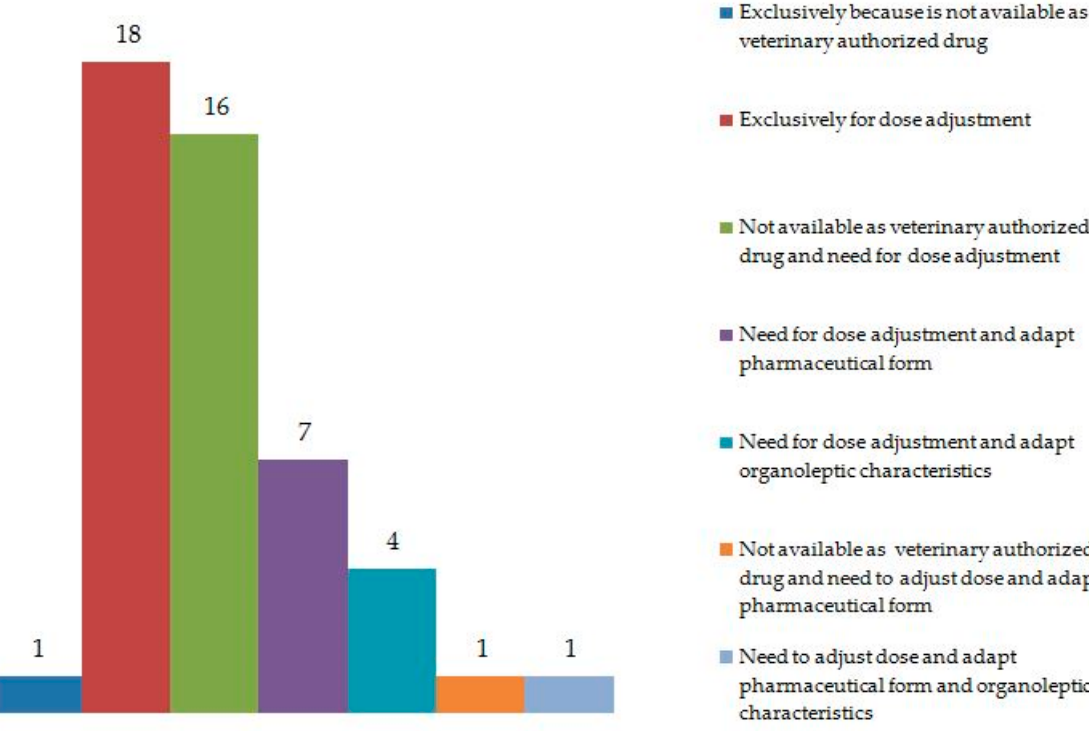
Figure 1. Reasons that justify the use of omeprazole ‐ compounded formulations by Portuguese GPs.